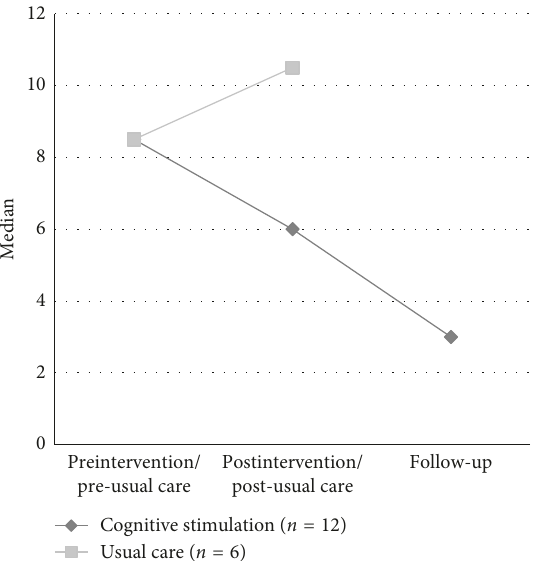
Figure 4: Median change of the Geriatric Depression Scale (GDS; max. 15 points; lower scores indicating less depressive symptoms) of the experimental (EG) and control group (CG) from pre- intervention/pre-usual care to postintervention/post-usual care to follow-up